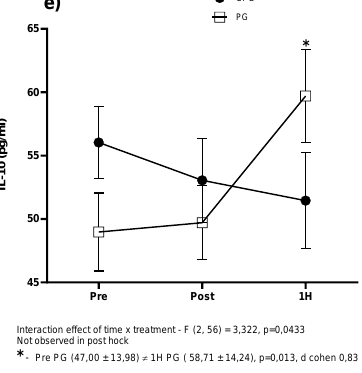
Figure 5. Circulating levels of interleukin-2 (IL-2) ( a ), tumor necrosis factor-alpha (TNF- α ) ( b ), interferon (IFN) ( c ), interleukin-6 (IL-6) ( d ) and interleukin-10 (IL-10) ( e ). Values represented by the mean ± SD, p -value, and effect size.